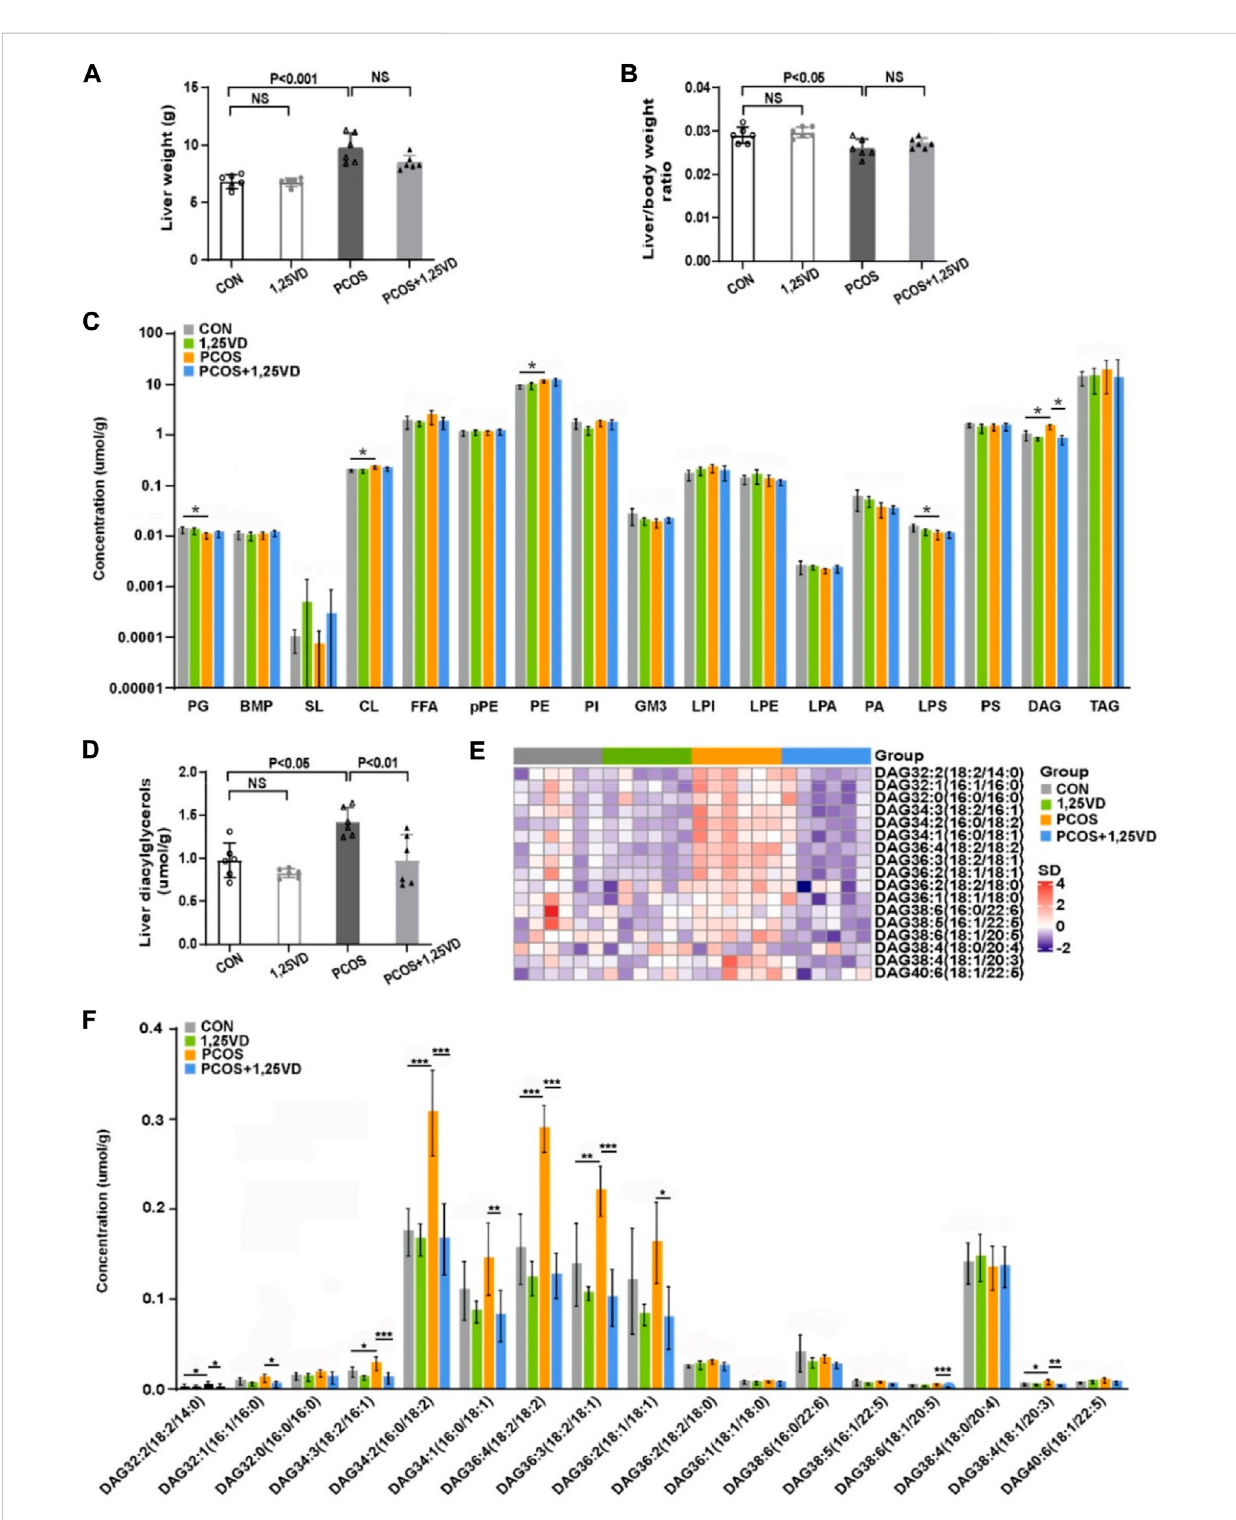
FIGURE 4 Comparison of the liver weight (A) , liver/body weight ratio (B) and hepatic lipid pro fi le (C – F) among the study groups. PG: Phosphatidylglycerols, BMP: Bis (monoacylglycerol) phosphate, SL: Sulfatides, CL: Cardiolipins, FFA: Free fatty acids, pPE: PlasmalogenPE, PE: Phosphatidylethanolamines, PI: Phosphatidylinositols, GM3: Monosialogangliosides, LPI: Lyso-PI, LPE: Lyso-PE, LPA: Lyso-PA, PA: Phosphatidic acids, LPS: Lyso-PS, PS: Phosphatidylserines, DAG: Diacylglycerols, TAG: Triaclglycerols. * p < 0.05, ** p < 0.01, *** p <